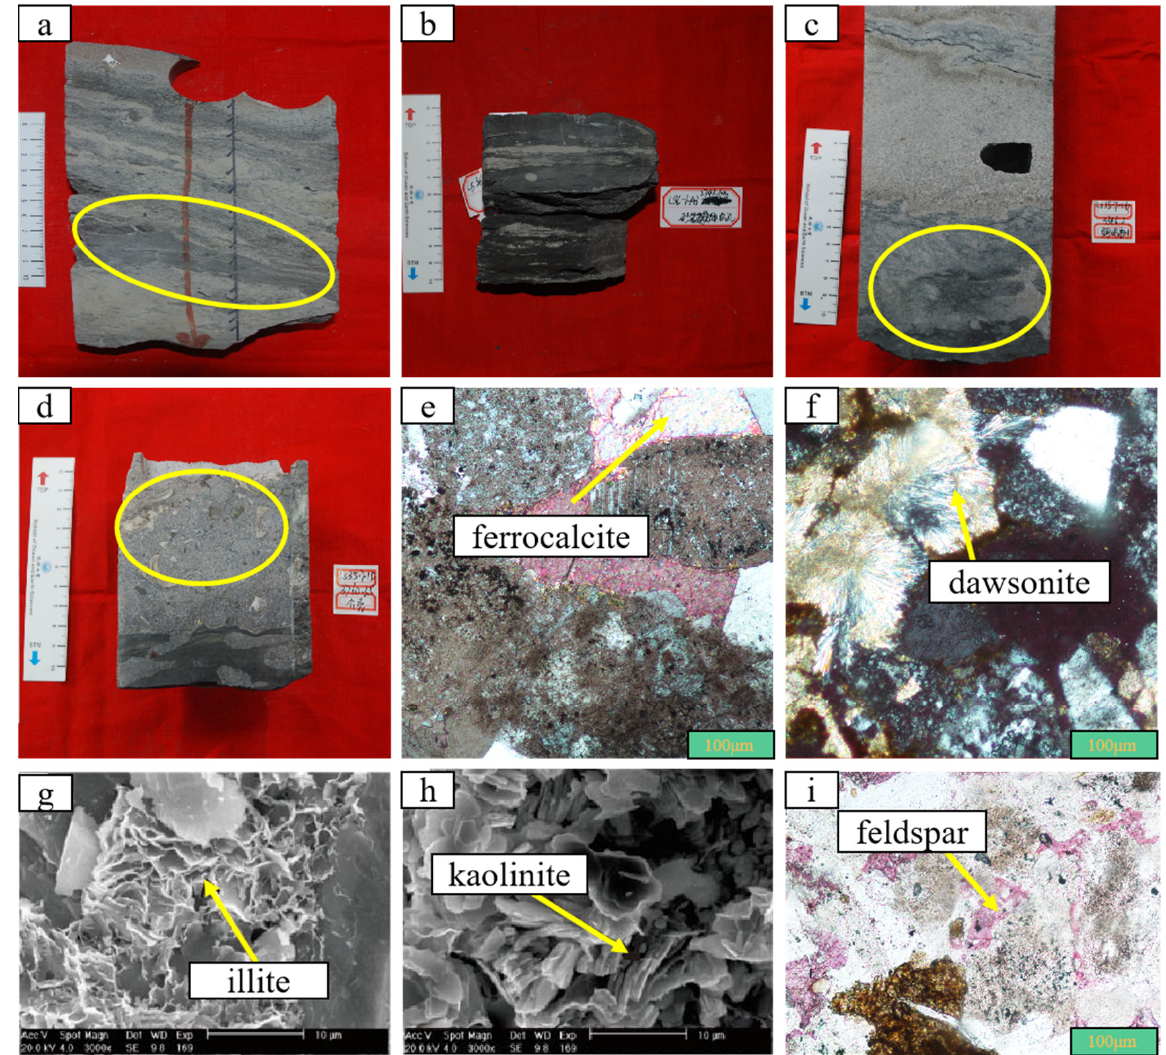
Figure 3. The petrological and mineralogical characteristics of the Paleocene in the West Lishui Sag. ( a ) Black carbon bits, B well, 2574.0 m, E 1 m 2 ; ( b ) thick mudstone, C well, 2743.10 m E 1 l 1 ; ( c ) Bouma sequence, D well, 3346.20 m, E 1 l 2 ; ( d ) shells, D well, 3760.35 m, E 1 l 1 ; ( e ) iron calcite cementation, D well, 3762.41 m, E 1 l 2 , (+); ( f ) dawsonite cementation, B well, 2579.00 m, E 1 m 2 , (+); ( g ) authigenic illite, with micropores of filler visible, B well, 2585.75 m, E 1 m 2 , SEM; ( h ) kaolinite crystals fill the gap with the broken shape, C well, 2253.68 m, E 1 m 2 ; SEM; ( i ) feldspar, B well, 2587.45 m, E 1 m 2 ( − ).